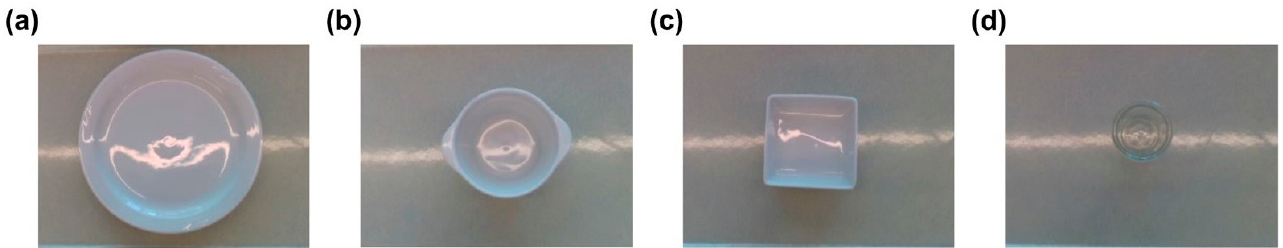
Figure 3. The plates used in the Geriatrische Klinik, St. Gallen: ( a ) round plate for main course; ( b ) bowl for soup; ( c ) square bowl for salad or dessert; ( d ) glass for dessert.